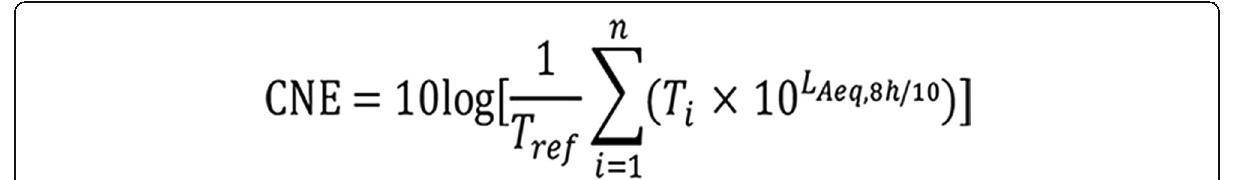
Fig. 1 The interpretation of CNE equation. Where Tref is equal to 1; n is the total number of different positions for the workers exposed to noise; i is the number of different posts; T is the time at different positions; L Aeq, 8h is the equivalent continuous sound level of 8 h for different